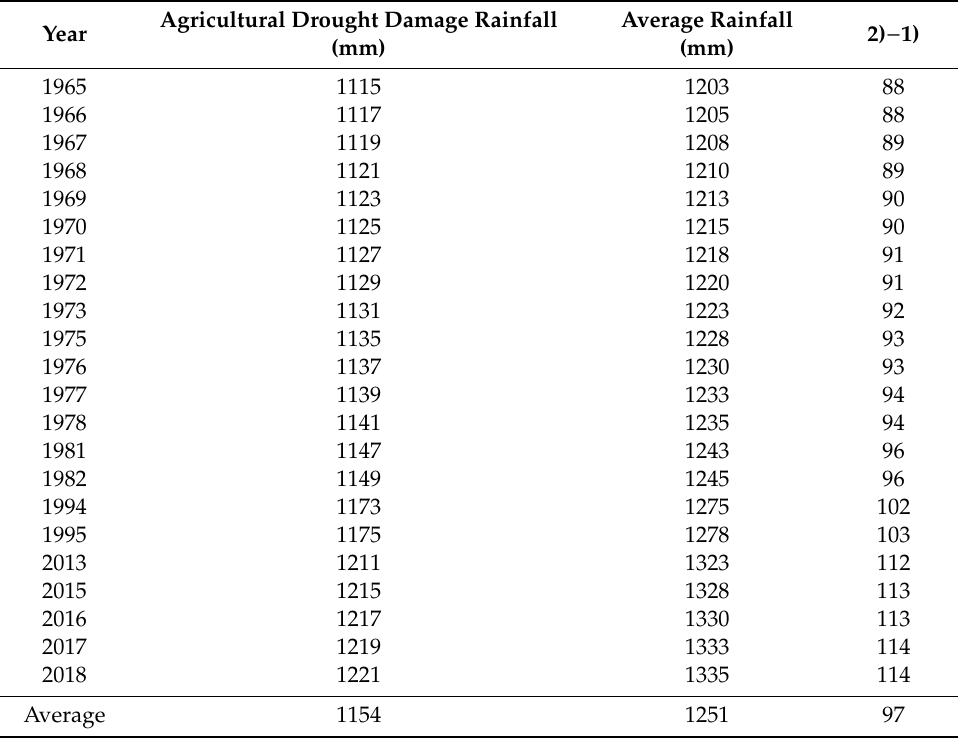
Table 5. Analysis of disaster-prevention rainfall by year, considering linear regression